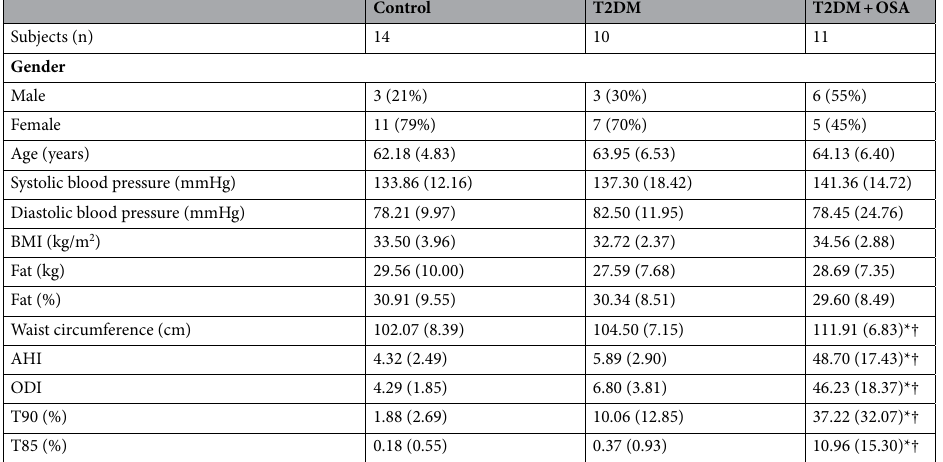
Table 1. Anthropometric and sleep characteristics of recruited subjects. Data are mean (SD), n (%). BMI, body mass index; AHI = apnoea hypopnea index; ODI, oxygen desaturation index. T90 = percentage of total sleep time with oxygen saturation less than 90%. T85 = percentage of total sleep time with oxygen saturation less than 85%. *Significant difference ( p < 0.05) compared with control group. † Significant difference ( p < 0.05) compared with T2DM